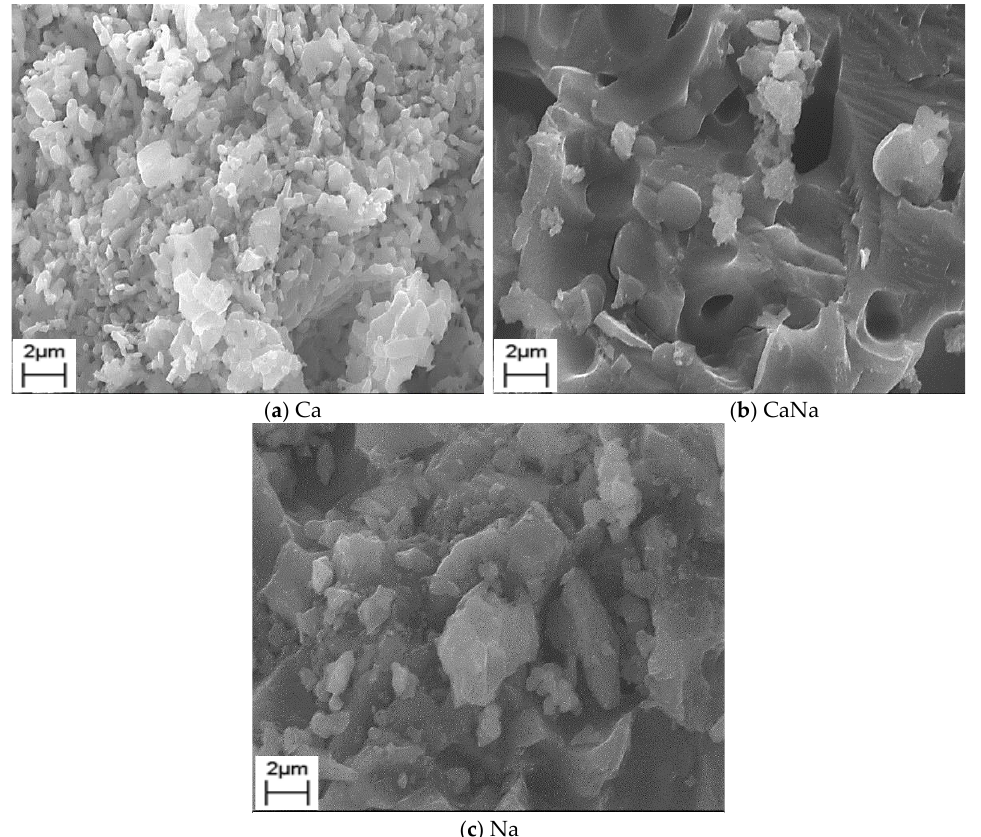
Figure 11. The SEM images of ceramic samples based on cement-salt stone: Ca ( a ), CaNa ( b ), and Na ( c ), after firing at a temperature of 900 ◦